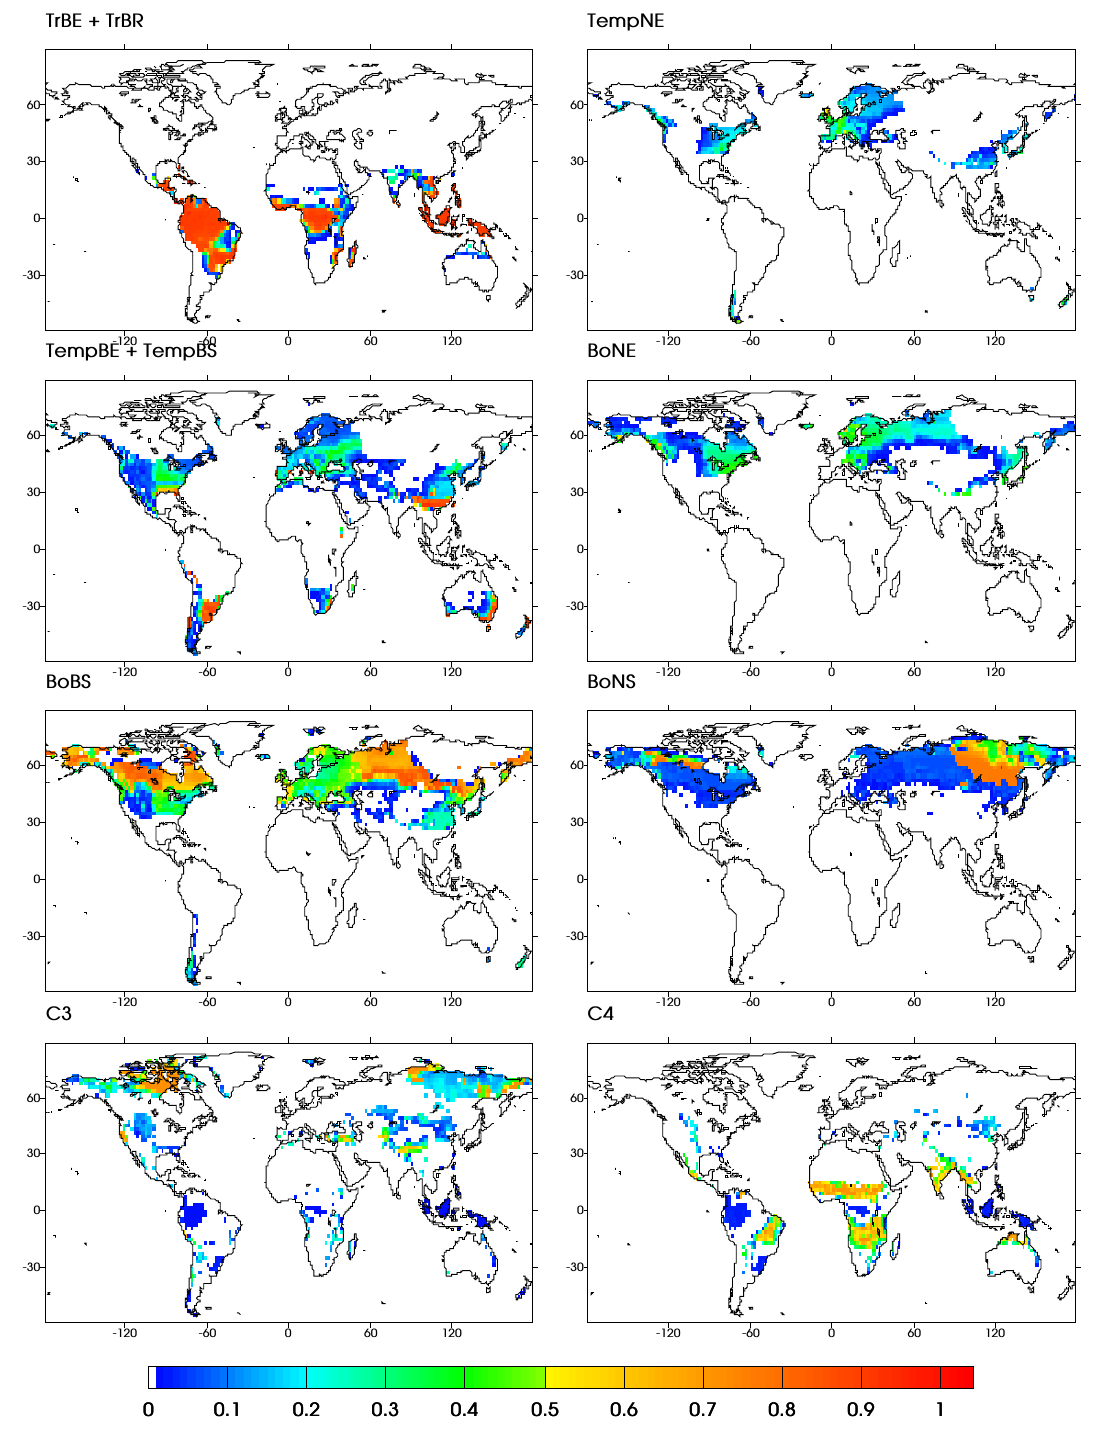
Fig. 5. Fractions of vegetation (annual maximum, in % of grid-cell) simulated by ORCHIDEE forced off-line by monthly CRU timeseries. Abbreviations: see Table